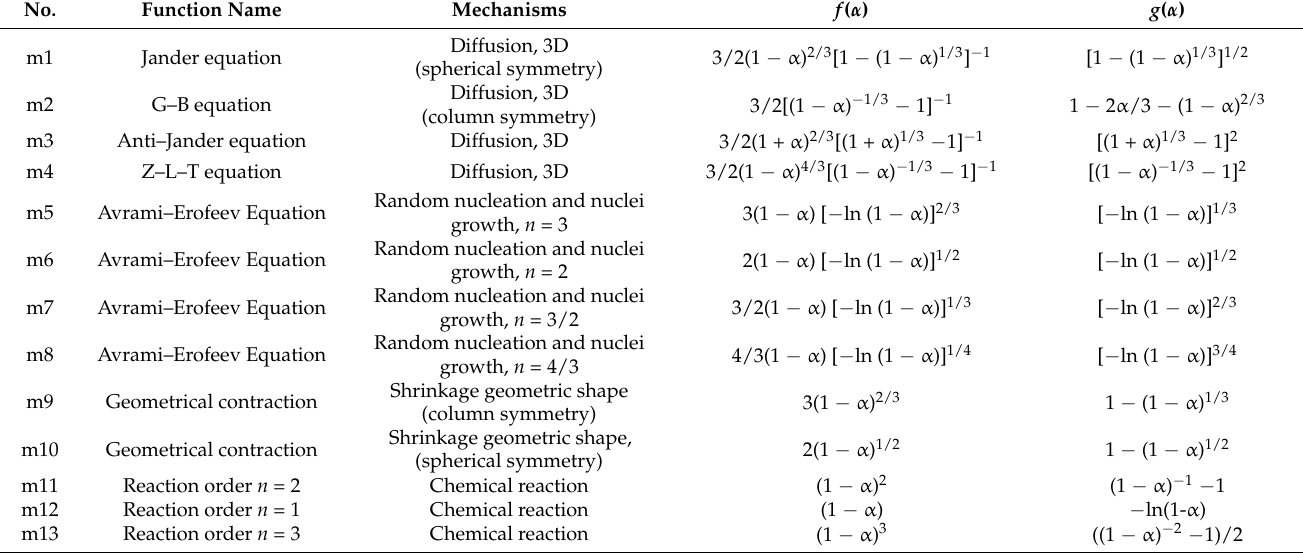
Table 1. Different degradation mechanisms with f ( α ) and g ( α ).